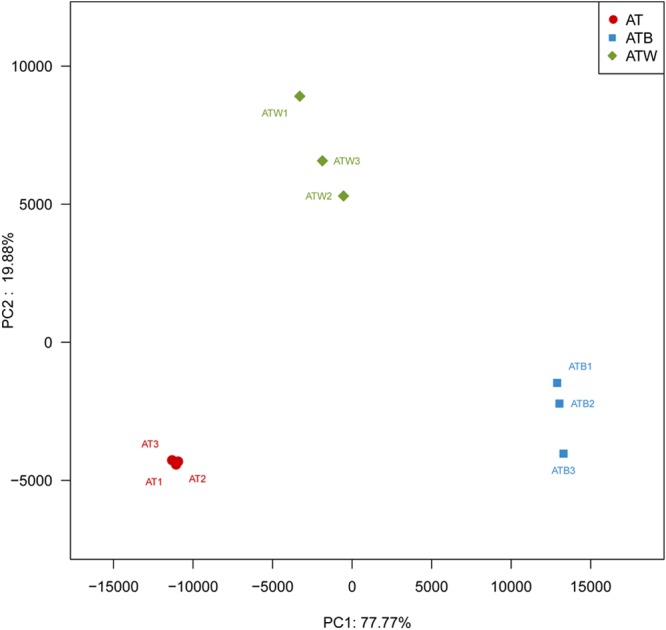
PCA analysis of multiple samples. Each sample is represented by a dot. PC1 explained 77.77% of the variation observed, and PC2 explained 19.88% of the variation.